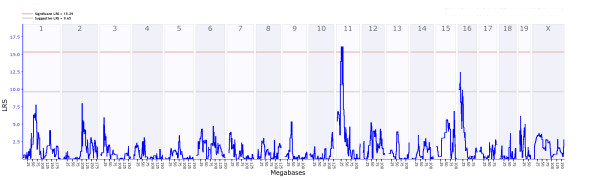
QTL Plot for Residual Neocortal Volume. The red upper line indicates the LRS value for genome-wide significant QTL and the lower grey line the level of suggestive QTL according to the criteria of Lander and Kruglyak [33]. There is a genome-wide significant linkage disequilibrium located in the proximal portion of chromosome 11. There is also a suggestive association on proximal chromosome 16. Notice that there is no significant association between neocortical volume and any marker on chromosome 19.